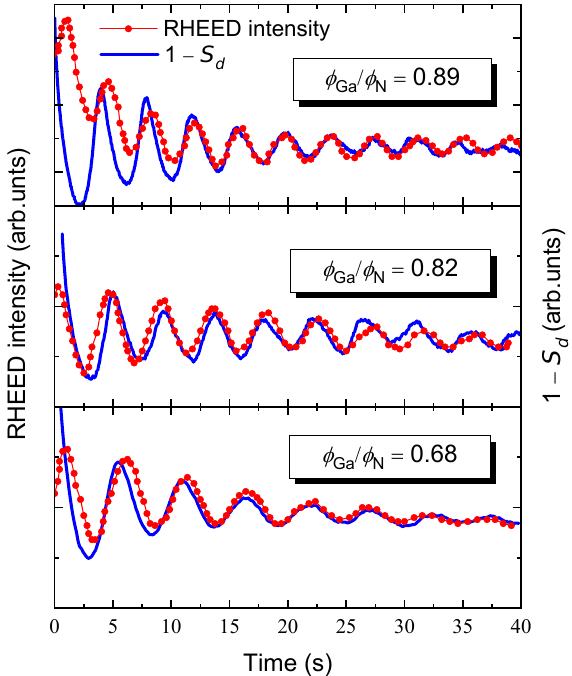
Figure 3. Comparison between the RHEED traces measured during GaN homoepitaxial growth at T = 730 ◦ C under different ratios φ Ga / φ N in Ref. [20] with the step density 1 − S d curves obtained from simulations with the fitted activation energies. In all cases, φ N = 0.28